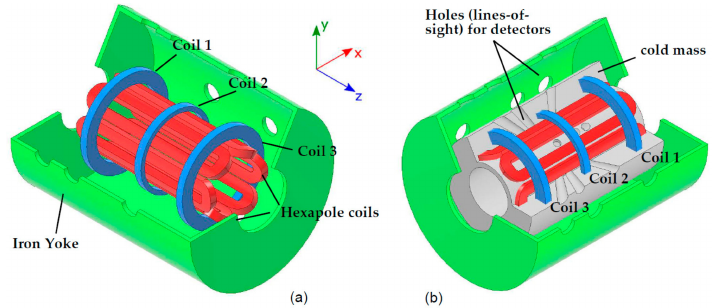
Figure 2. ( a ) Render 3D view of the magnetic system designed and numerically simulated in OPERA. The plot shows the three axial coils (in blue) plus the hexapolar coils (in red), surrounded by the iron yoke (in green). ( b ) The same setup of ( a ), showing also the cold-mass (in gray). The holes (lines of sight) designed to allow radial inspection of the plasma by gamma-ray detectors and plasma diagnostics are included as well.